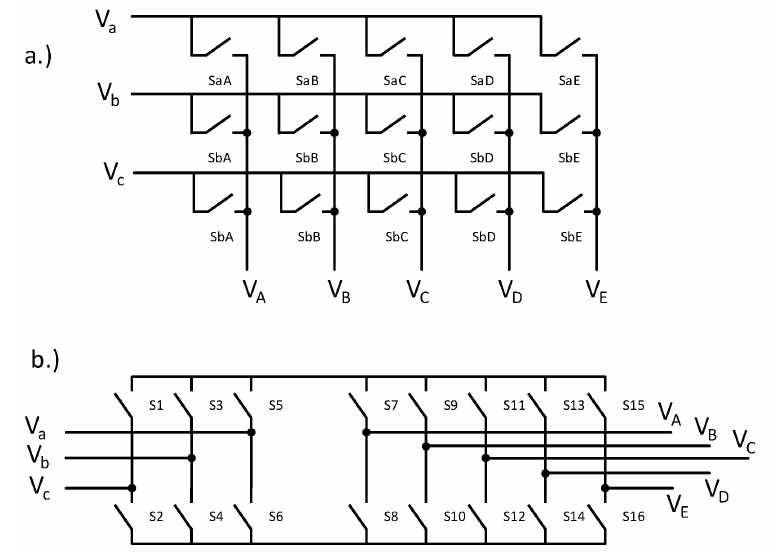
Figure 1. Matrix converter topology schematics: ( a ) direct and ( b )